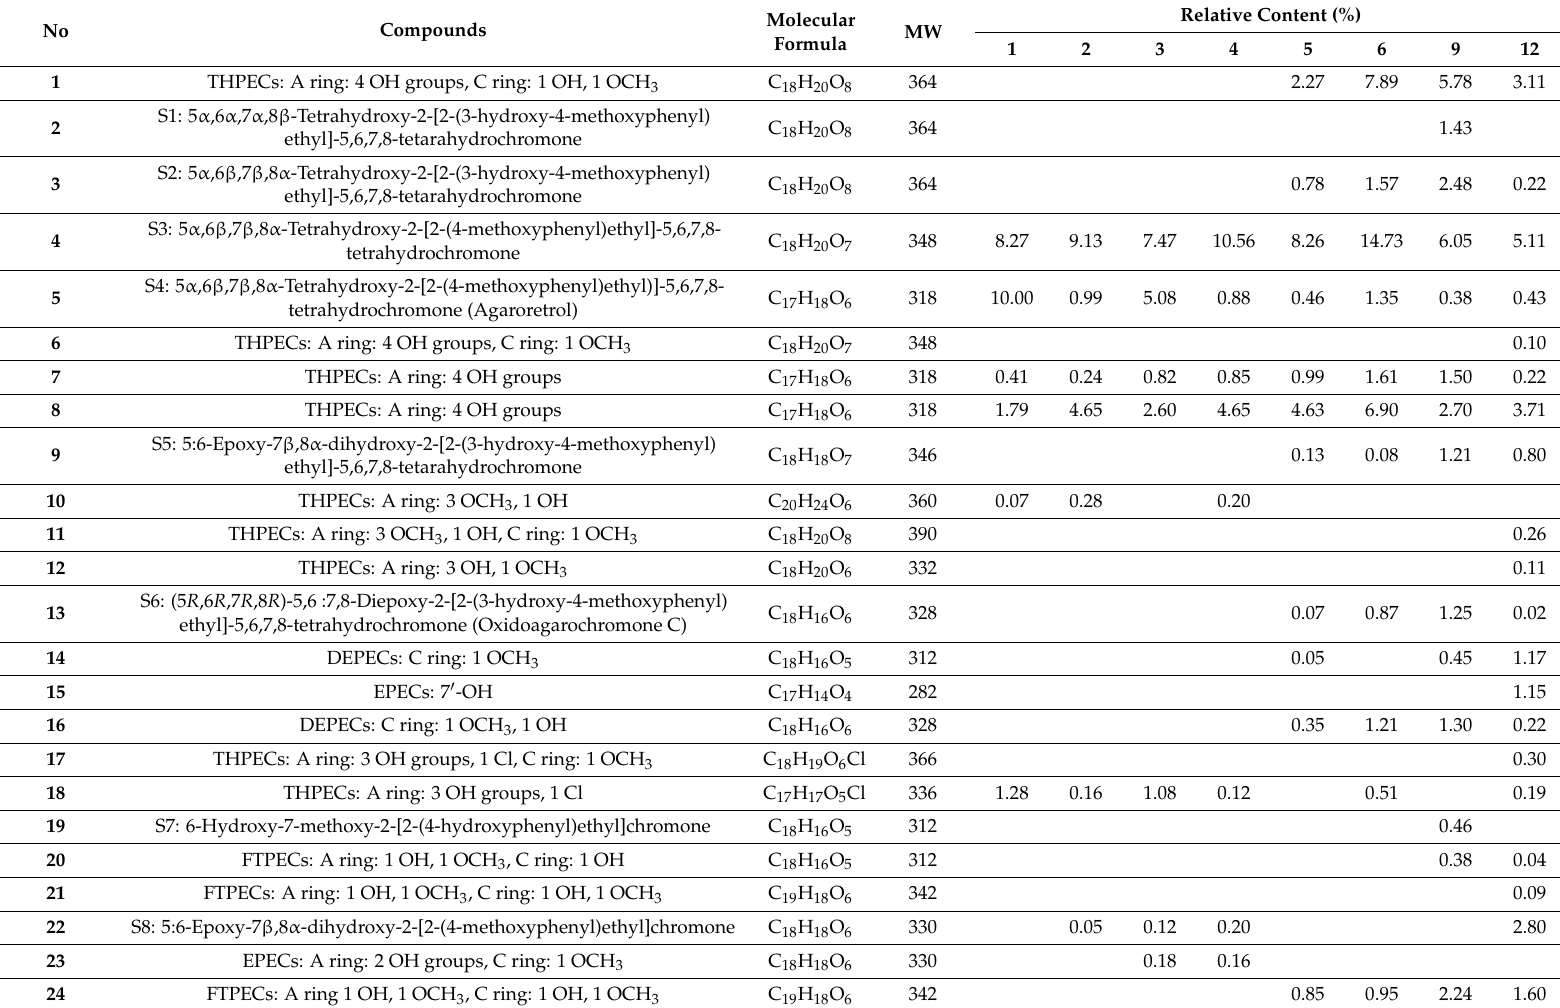
Table 2. The UPLC-MS analysis results of agarwood samples produced from the 1st to 12th